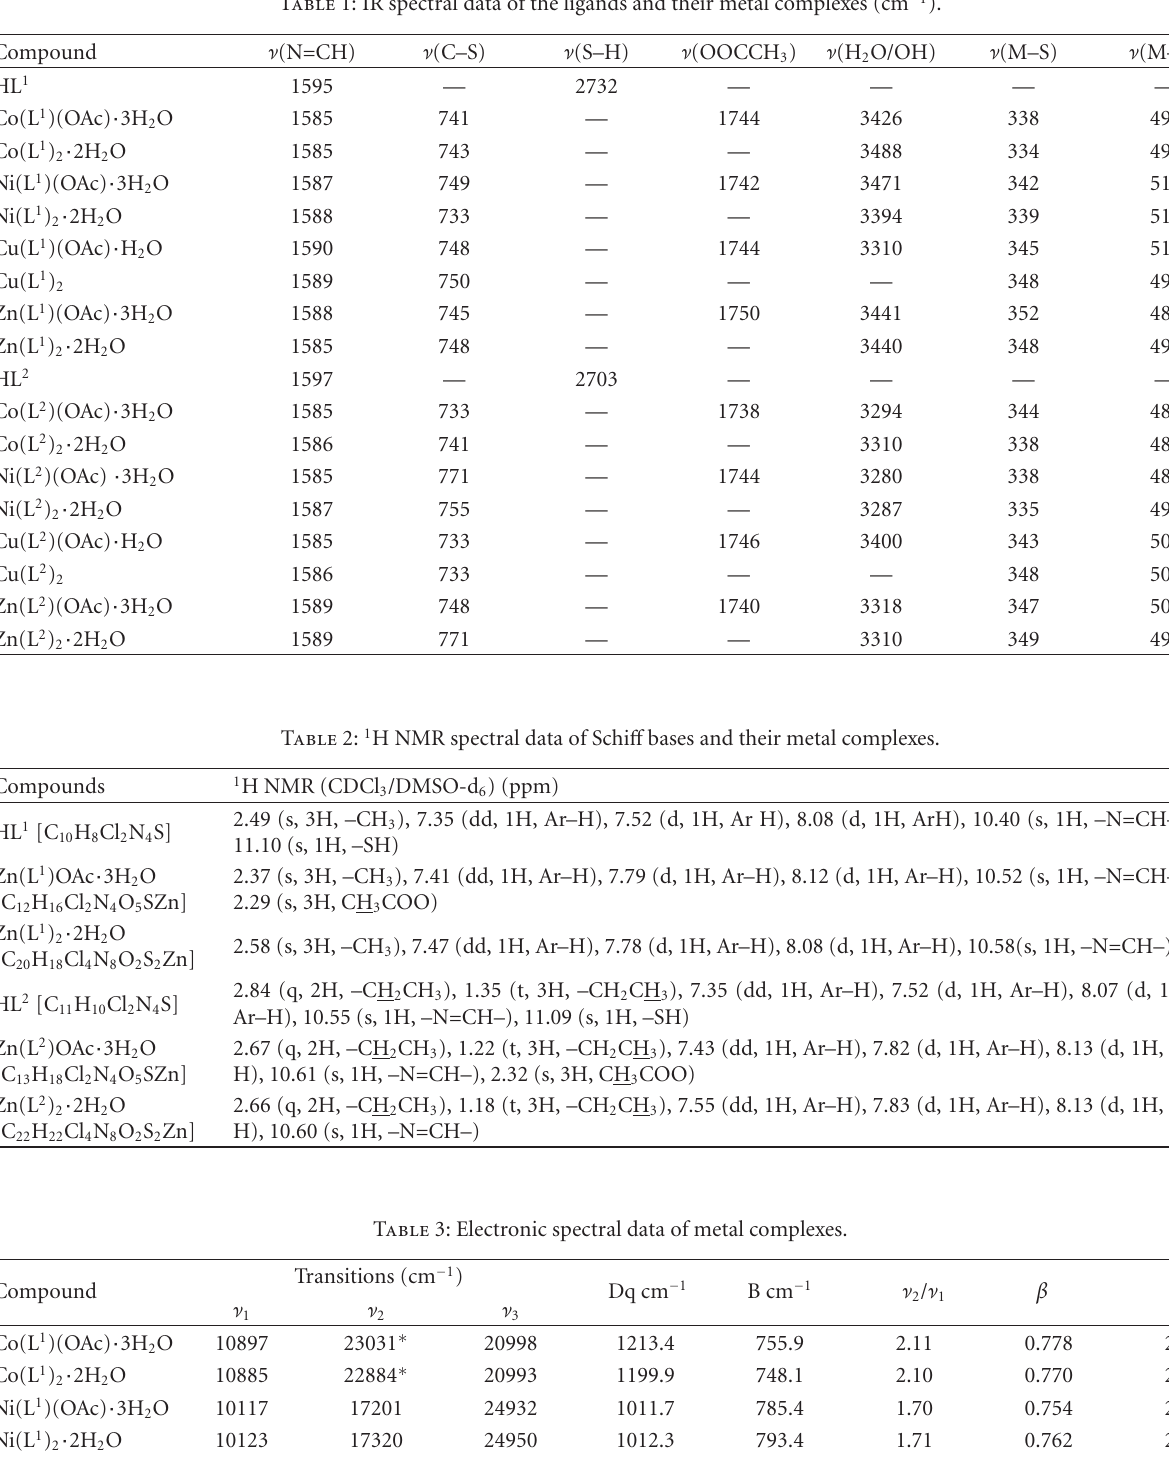
Table 1: IR spectral data of the ligands and their metal complexes (cm − 1 ).